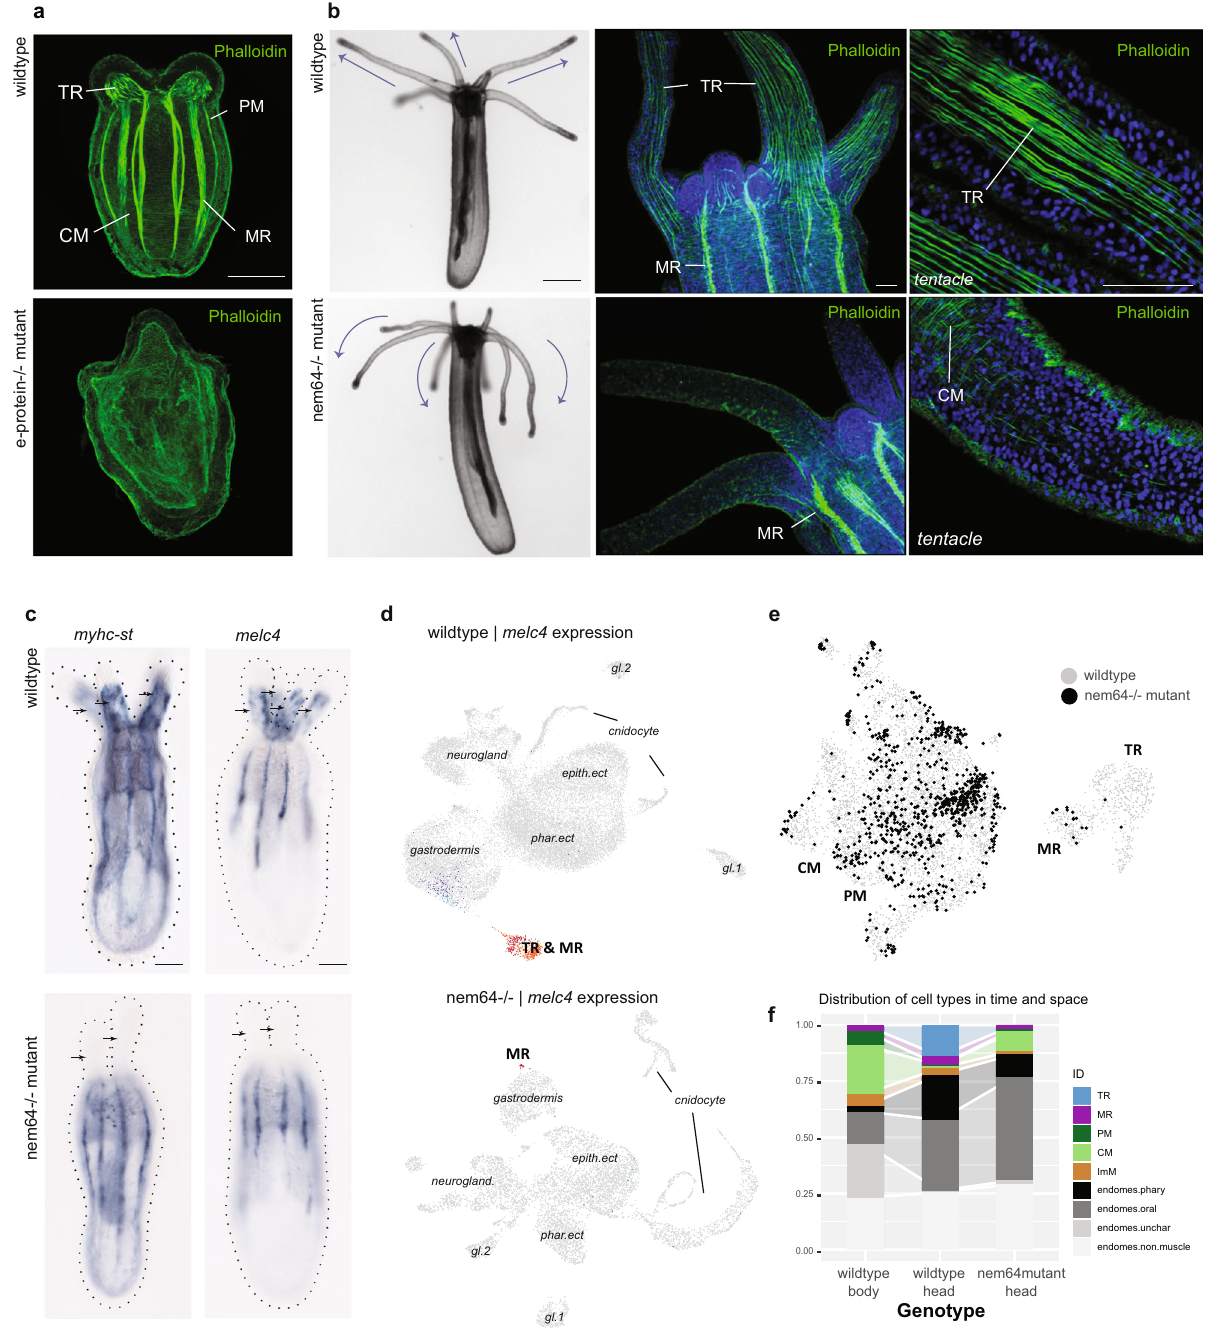
Fig. 4 | Gene perturbation selectively eliminates muscle. Wild-type animals are shown in the upper row panels and mutant animals in the lower row panels. a e-protein − / − mutant: Phalloidin staining in control (upper) and mutant (lower). b nem64 − / − mutant: Control animals (upper) show extended tentacles with intact phalloidin-positive retractor muscles, whereas mutant animals (lower) exhibit droopy nonresponsive tentacles and the absence of phalloidin-positive muscle within the tentacle retractors. c Structural marker genes ( myhc-st , melc4 ) are lost within the tentacles of nem64 − / − mutant animals (bottom). Outline of animal